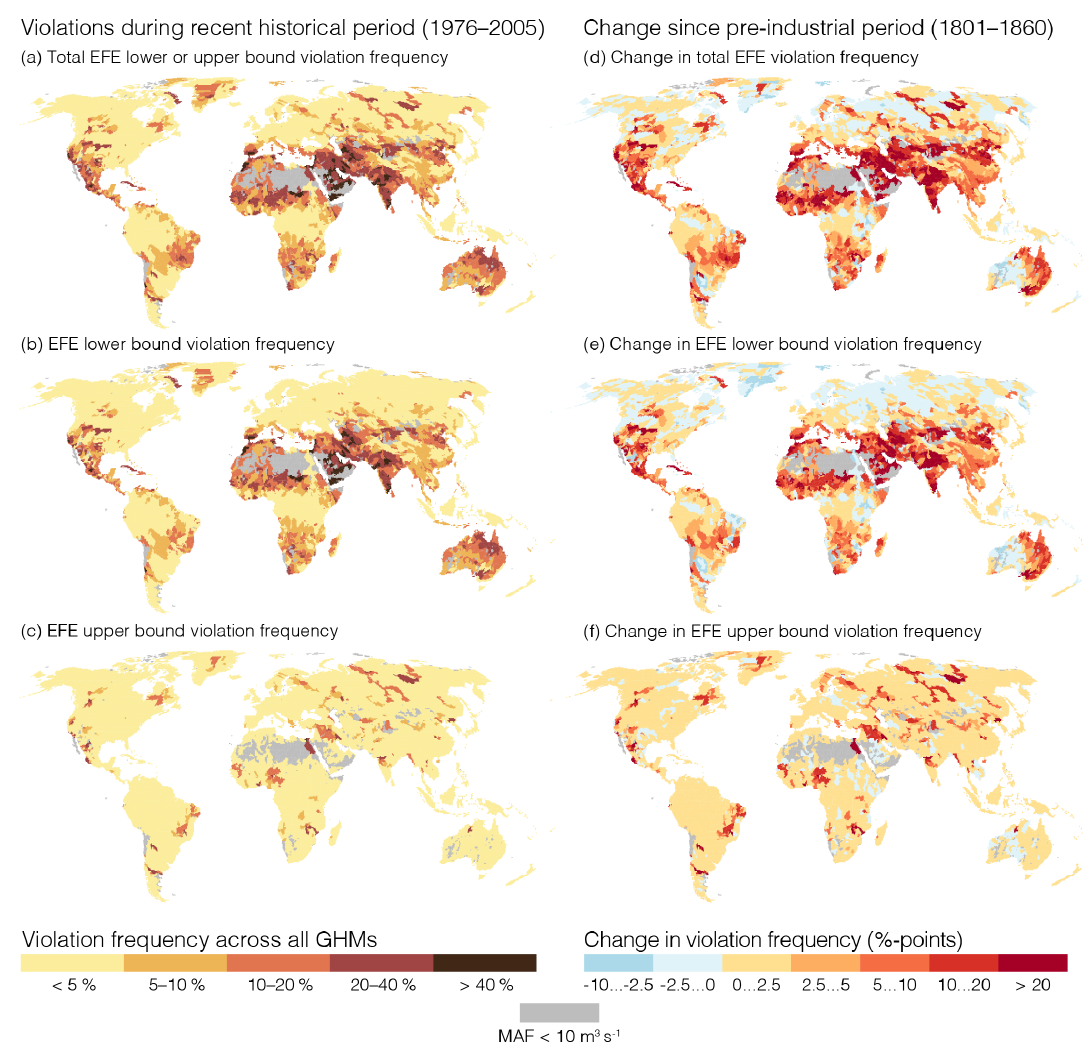
Figure 2. Frequency of environmental flow envelope (EFE) violations during the recent historical period (1976–2005); for both upper and lower bounds (a) , lower bound only (b) , and upper bound only (c) , aligned with the change in violation frequency since the pre-industrial period (1801–1860) (d–f) . All values are computed across four global hydrological models (GHMs). Sub-basins with mean annual flow (MAF) less than 10m 3 s − 1 at the sub-basin outlet are excluded. Case examples of how the recent historical discharge compares with the EFE in different flow regimes are shown in Fig.